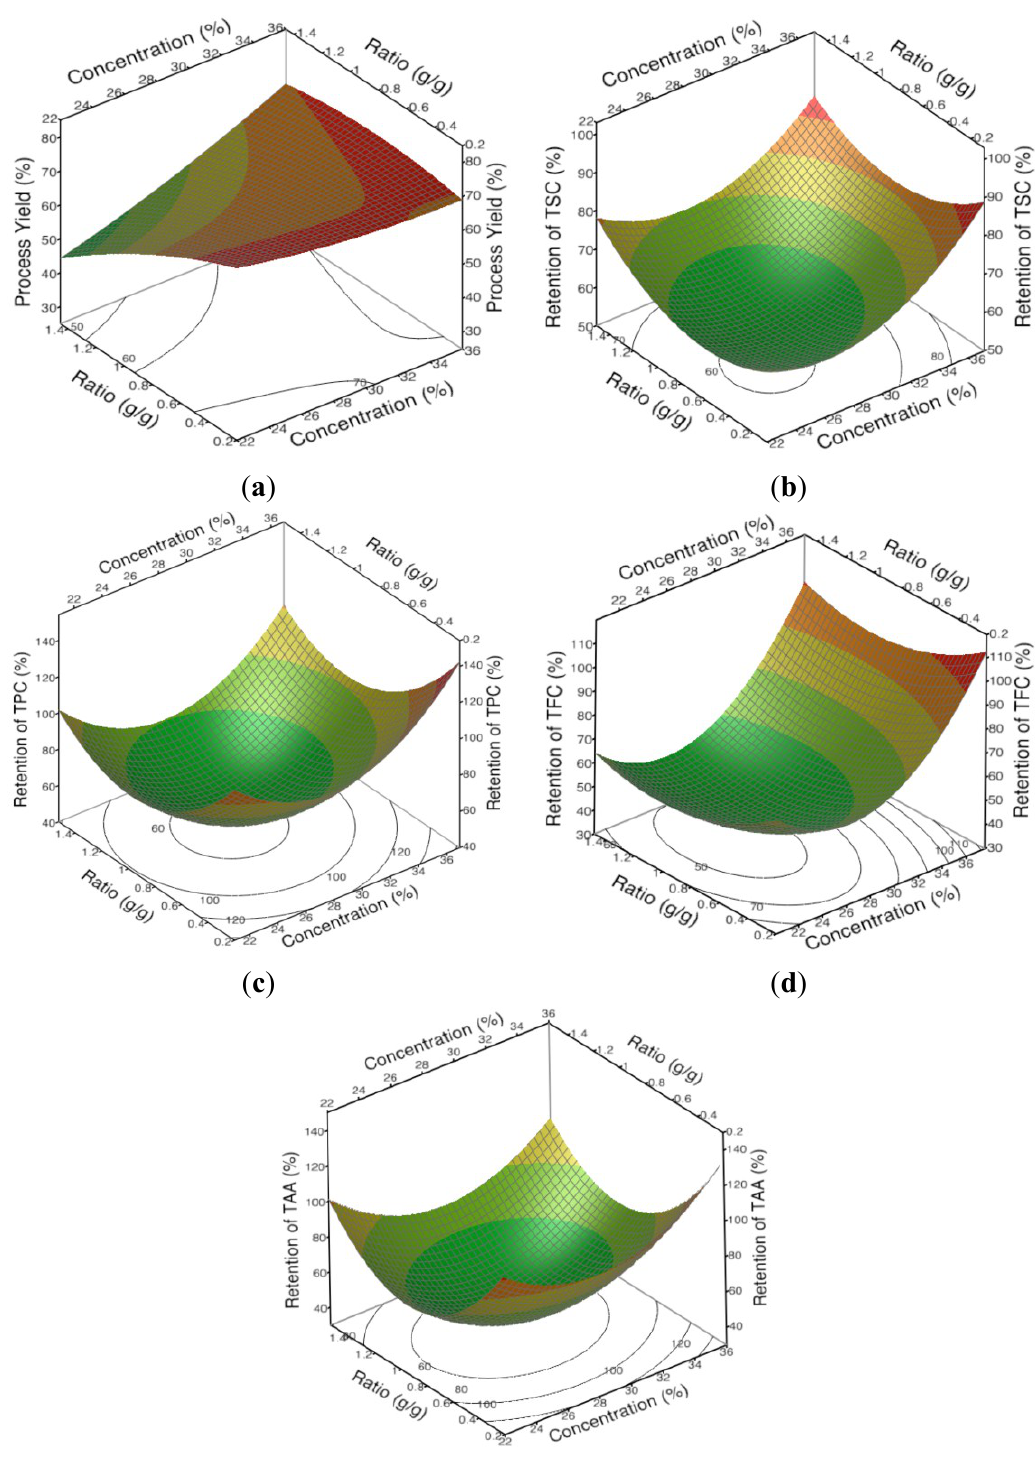
Figure 1. The 3D response surface and 2D contour plots of the ( a ) process yield and the retentions of ( b ) total saponin content (TSC); ( c ) total phenolic content (TPC); ( d ) total flavonoid content (TFC) and ( e ) total antioxidant activity (TAA) in response to concentration (X 1 ) and ratio (X 2